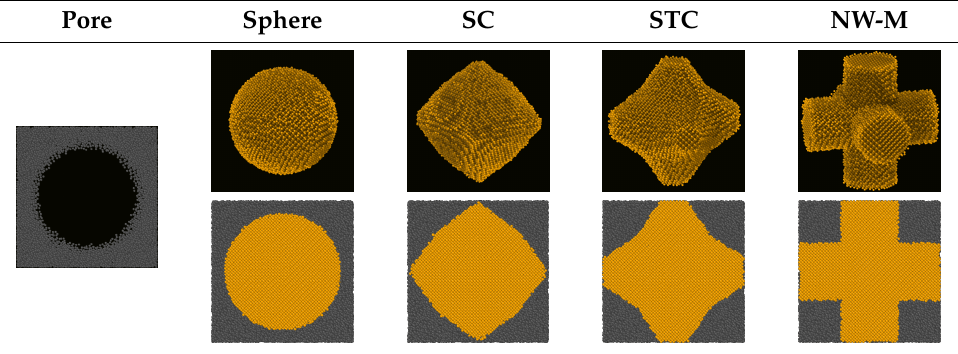
Table 1. Freestanding nanoparticles (first row) and a cross-section of NIs embedded in an a-Si matrix (in dark gray) cross-section (second row). In each case, the NI represents 30% of the volume of simulation